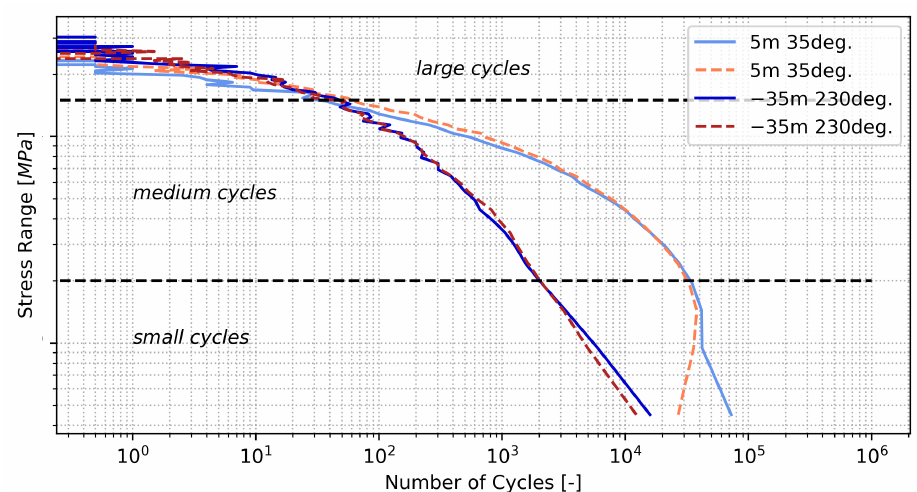
Figure 16. Full fatigue spectrum of measurement (solid) and estimation (dashed).